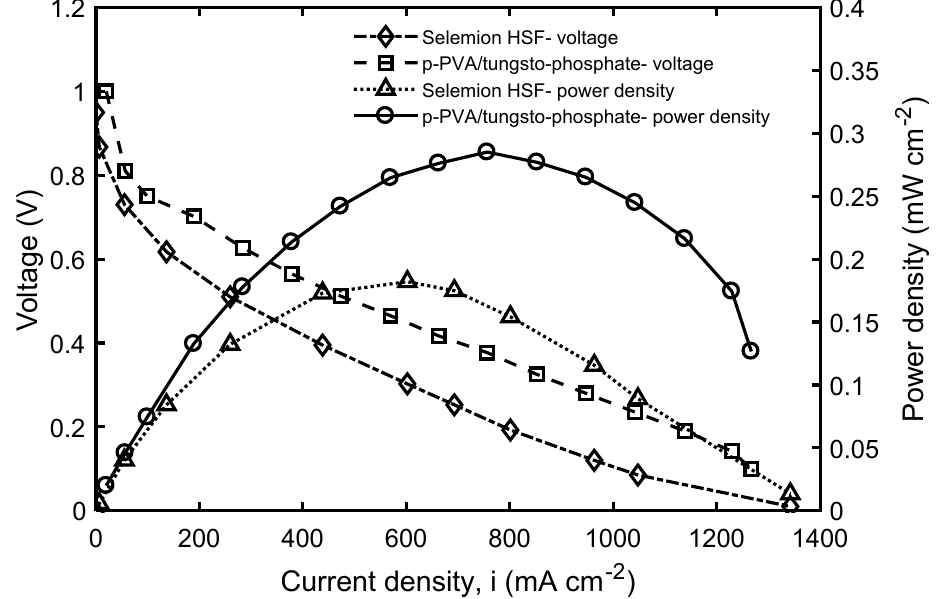
Figure 8. The performance of Fe 3+ /H 2 electrochemical cell with the p-PVA/tungsto-phosphate and Selemion HSF membranes.